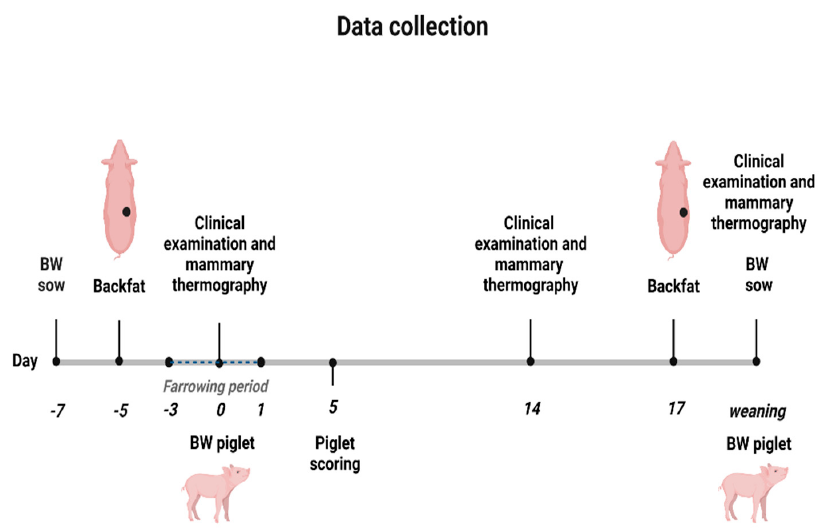
Figure 1. Overview concerning the time and data collection plan. BW; bodyweight (Figure was created with BioRender.com). Table 1. Nutrient contents in the gestation and lactation diet in accordance with the declaration (g/kg as fed).